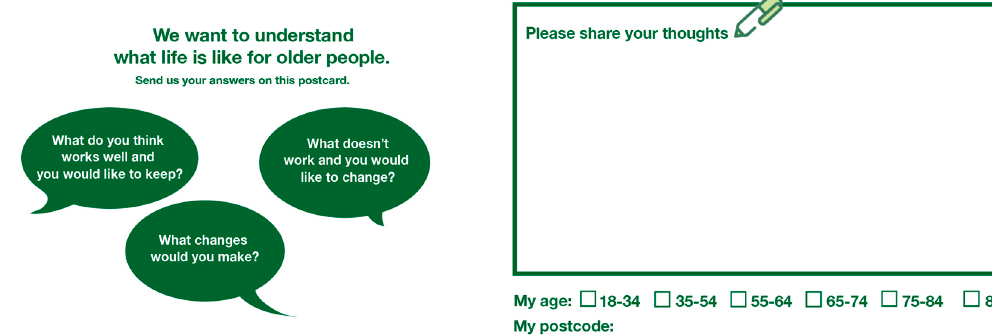
Figure 1. Front and back of feedback postcard.